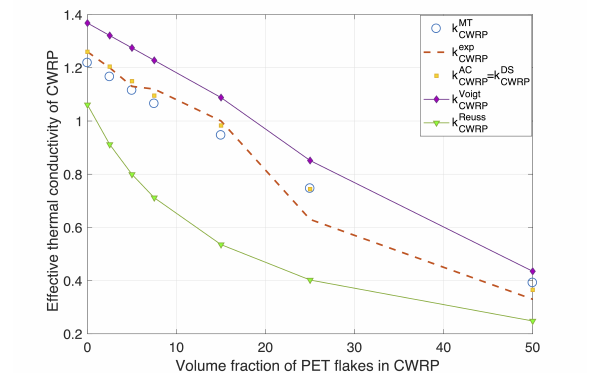
Fig. 5. Effect of volume fraction of PET flakes on macroscopic thermal conductivity of CWRP